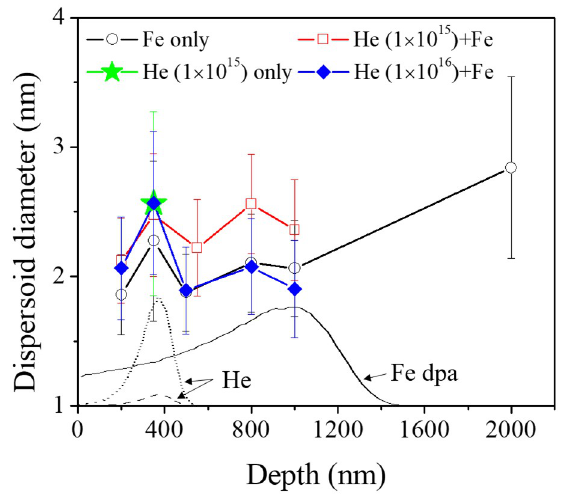
Figure 9. Average dispersoid diameters of Fe irradiated only, He implanted only, and He + Fe irradiated samples as a function of depth. The SRIM calculations are superimposed. The average size decreased within the ion range, but no significant difference was observed between the specimens.